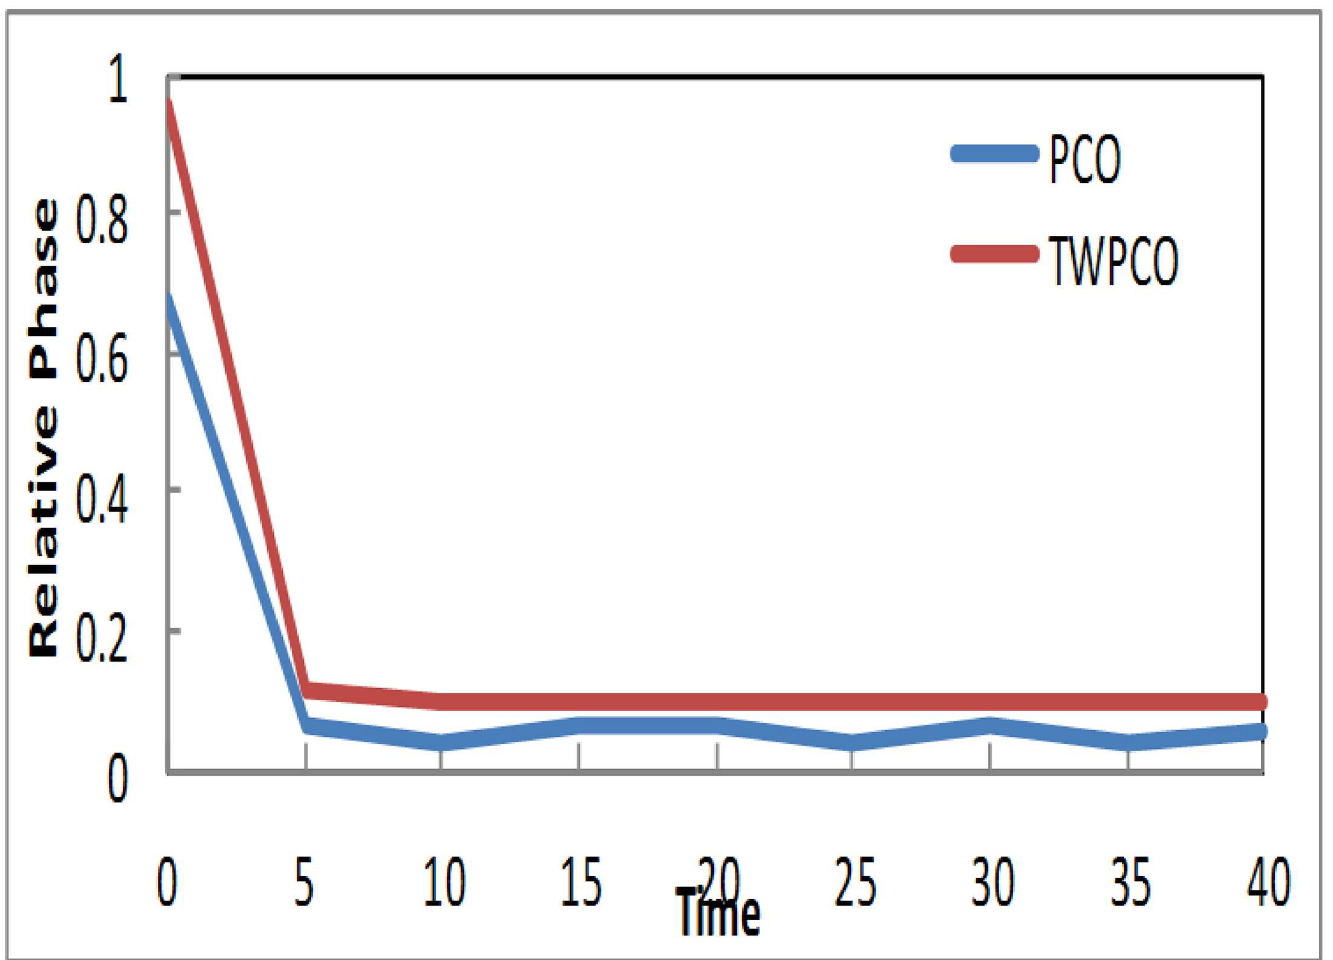
Fig 7. Relative Phase of Sensor TWPCO and PCO in regard to Node